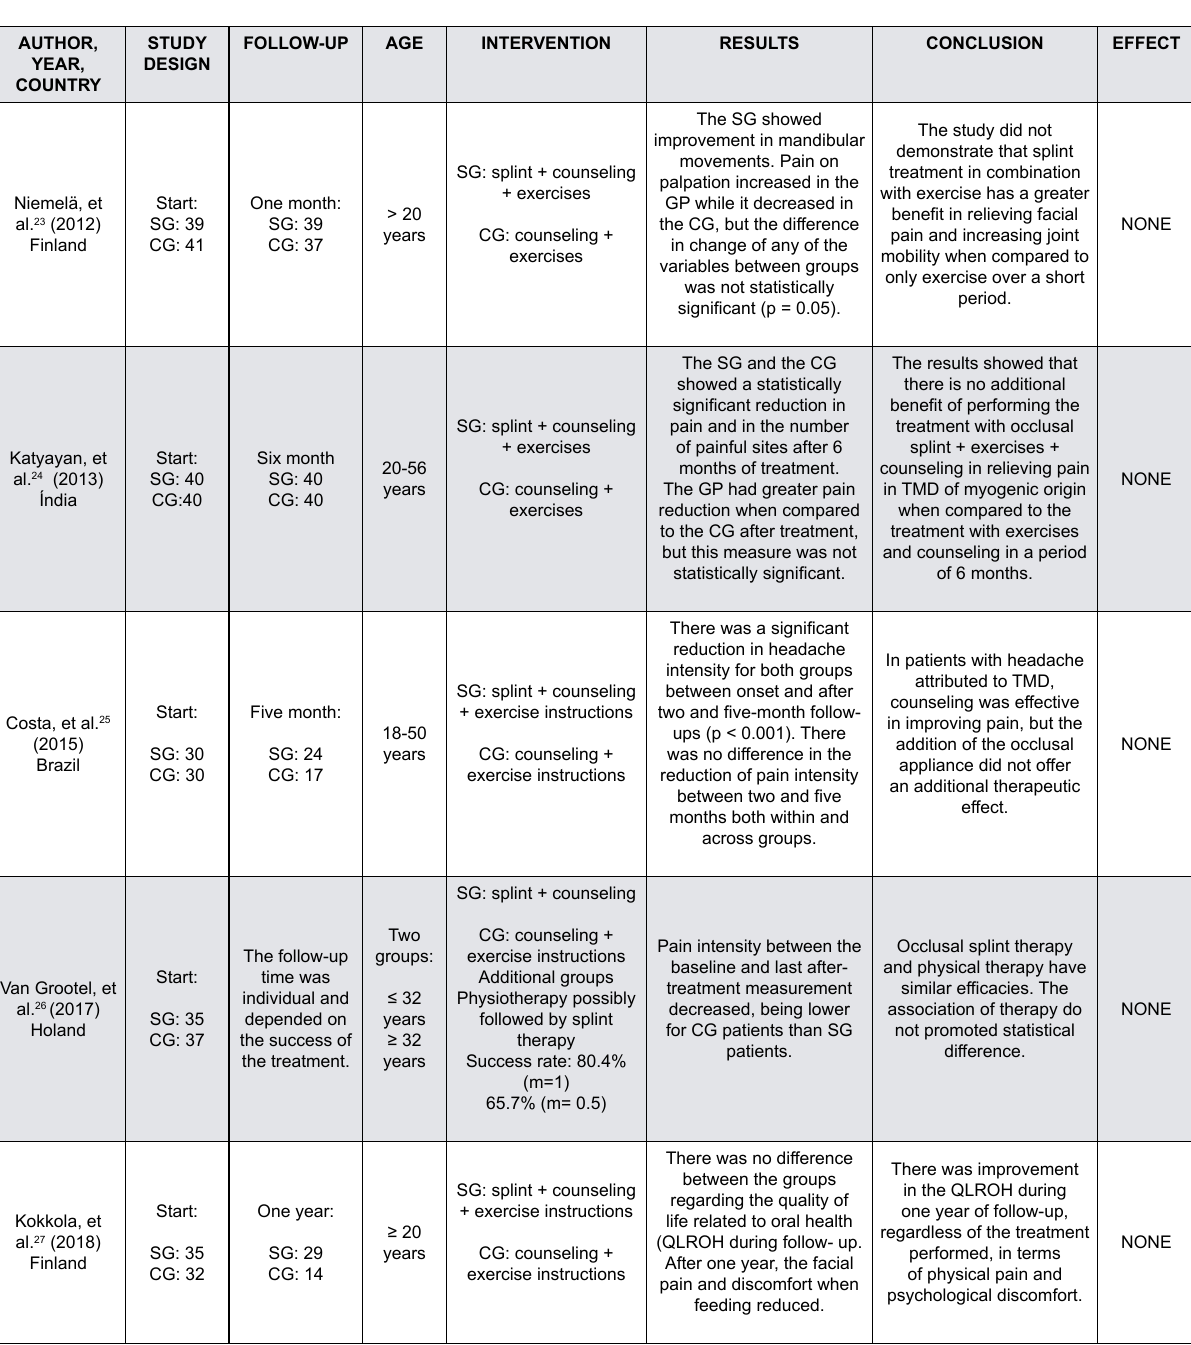
Figure 3- Characteristics of included